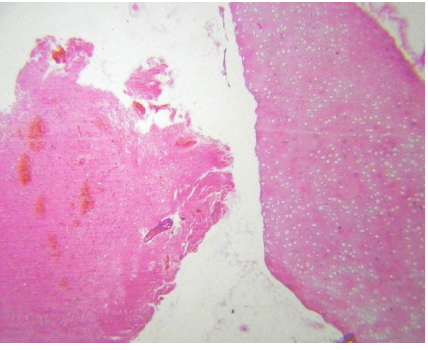
Figure 6: Section showing cartilage with brain tissue (H & E 4x